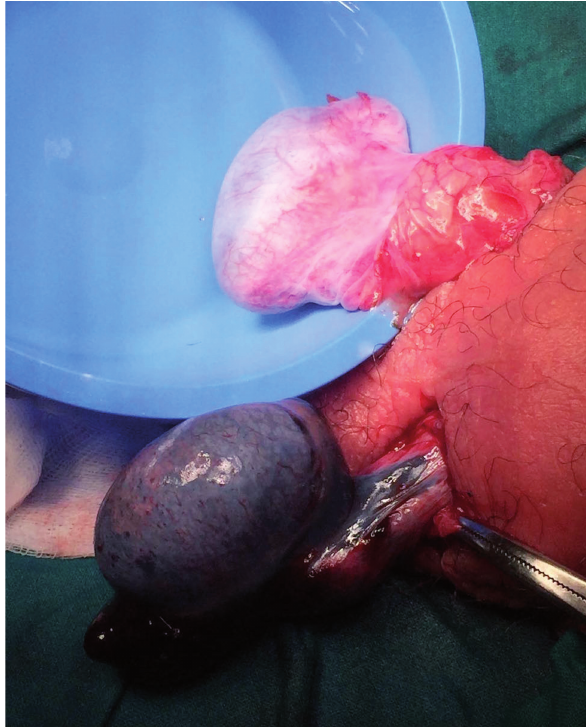
Figure 2 - After bilateral detorsion, right testis recovered a normal coloration, in contrast of left testis with established